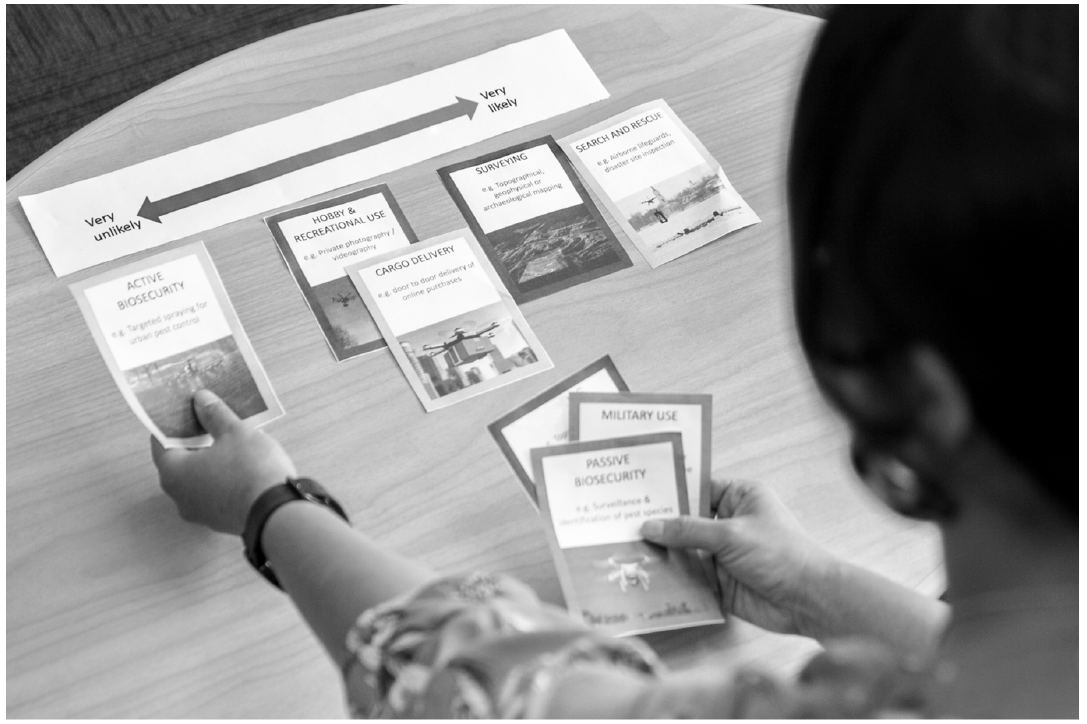
Figure 1. Example of unmanned aerial vehicle (UAV) use categories placed along the social licence to operate (SLO) spectrum .